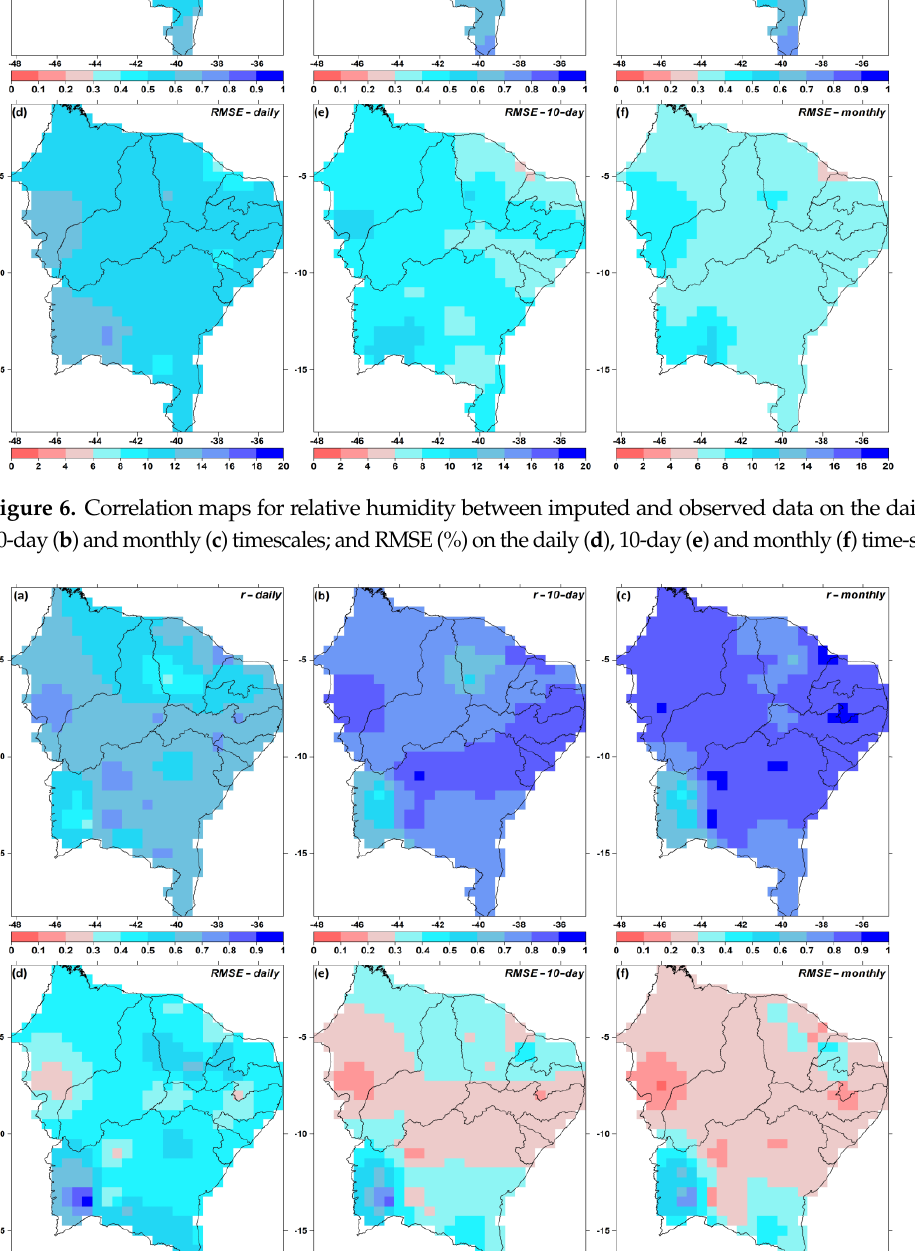
Figure 7. Correlation maps for atmospheric pressure between imputed and observed data on the daily ( a ), 10-day ( b ) and monthly ( c ) timescales; and RMSE (hPa) on the daily ( d ), 10-day ( e ) and monthly ( f ) time-scales.